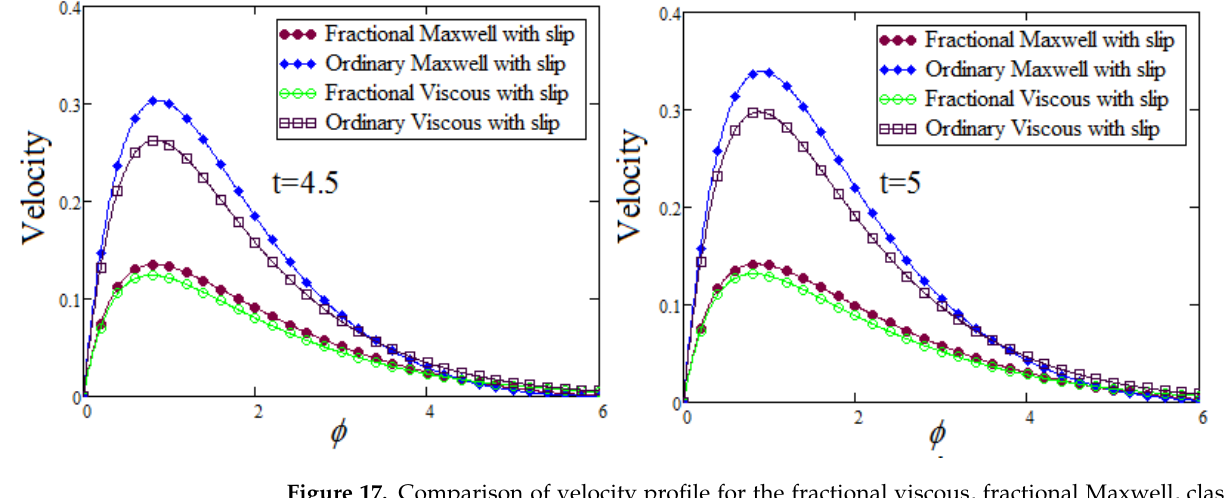
Figure 17. Comparison of velocity profile for the fractional viscous, fractional Maxwell, classical viscous, and classical Maxwell fluids in the presence of slip conditions at two different levels of time, when Pr = 12, Gr = 5, ℘ = 0.4, Gm = 3.5, ω = 0.5, Sc = 9, α = 0.5 β = 0.3, and γ = 0.4.